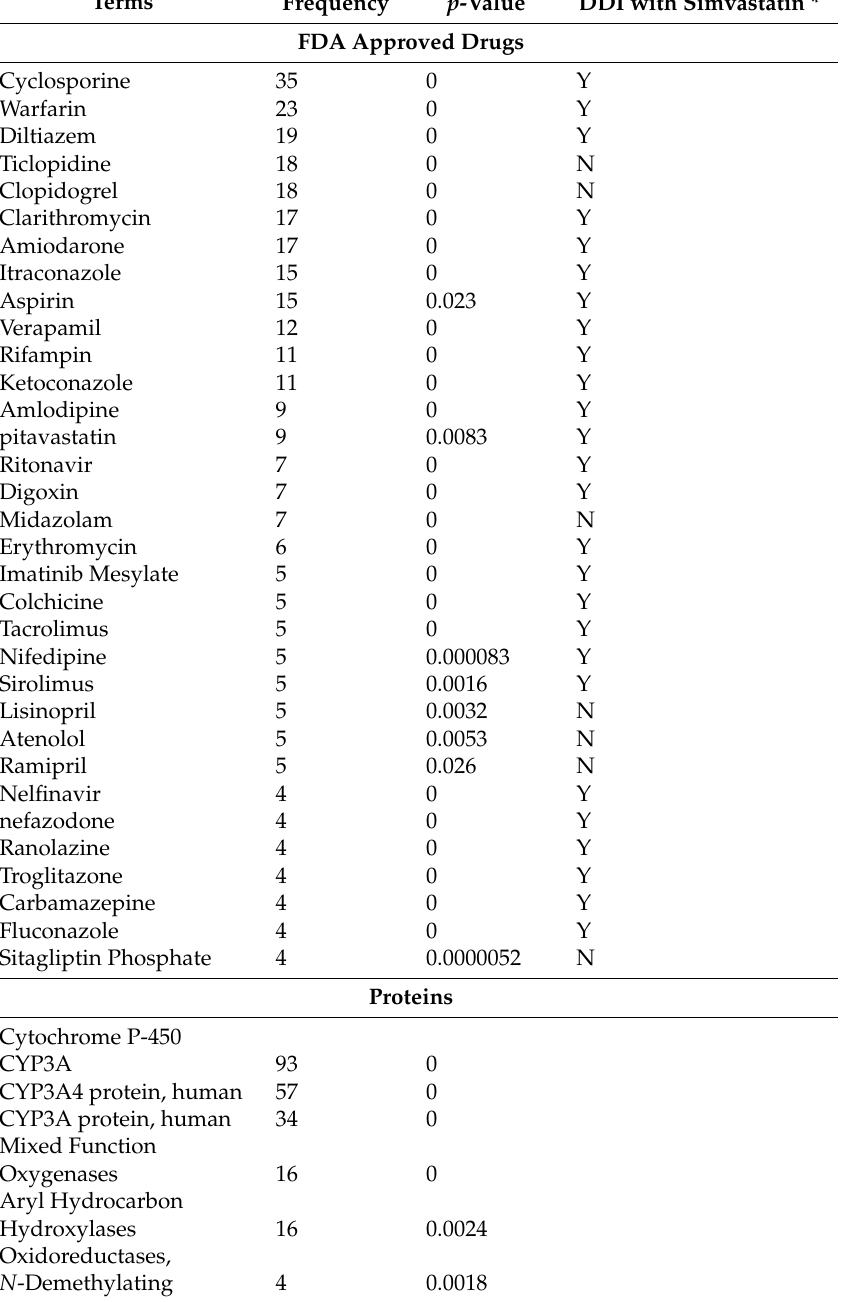
Table 2. The proteins and Food and Drug Administration (FDA) approved drugs identified from CuDDI for searching simvastatin with the frequency >3 and adjusted p -value <